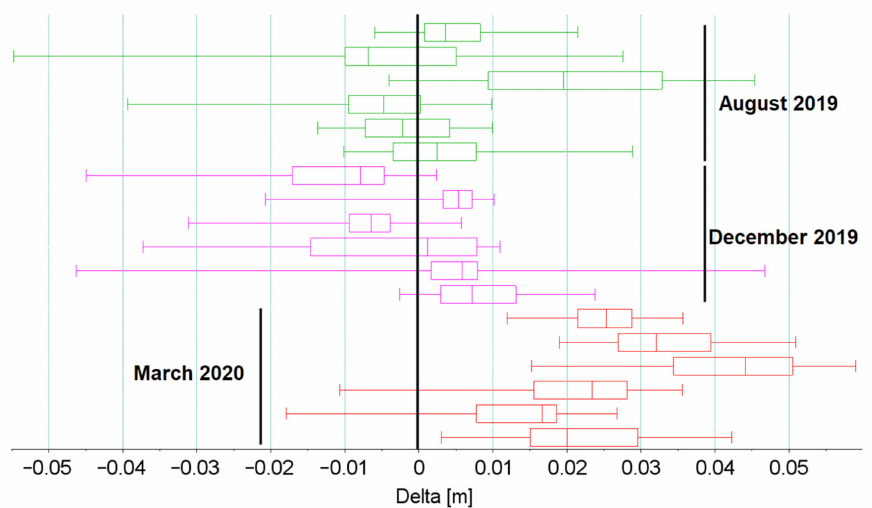
Figure 14. Box plot of deviations of the track axis reconstructed in vertical plane using different measuring instruments with respect to the static